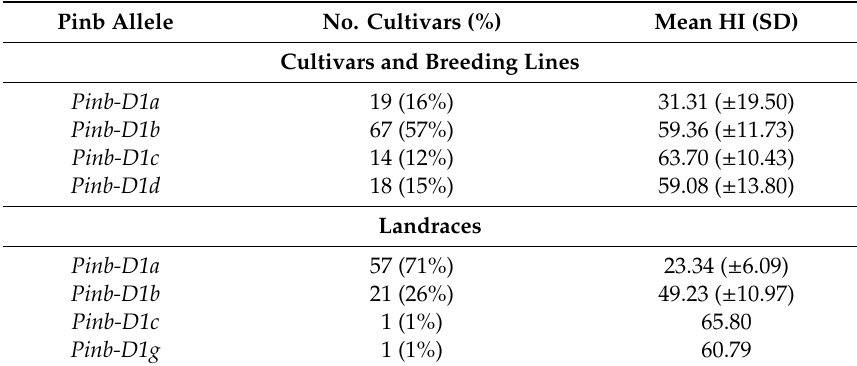
Table 1. The Pinb allele frequency in the tested genotypes and mean hardness index (HI) in each allele